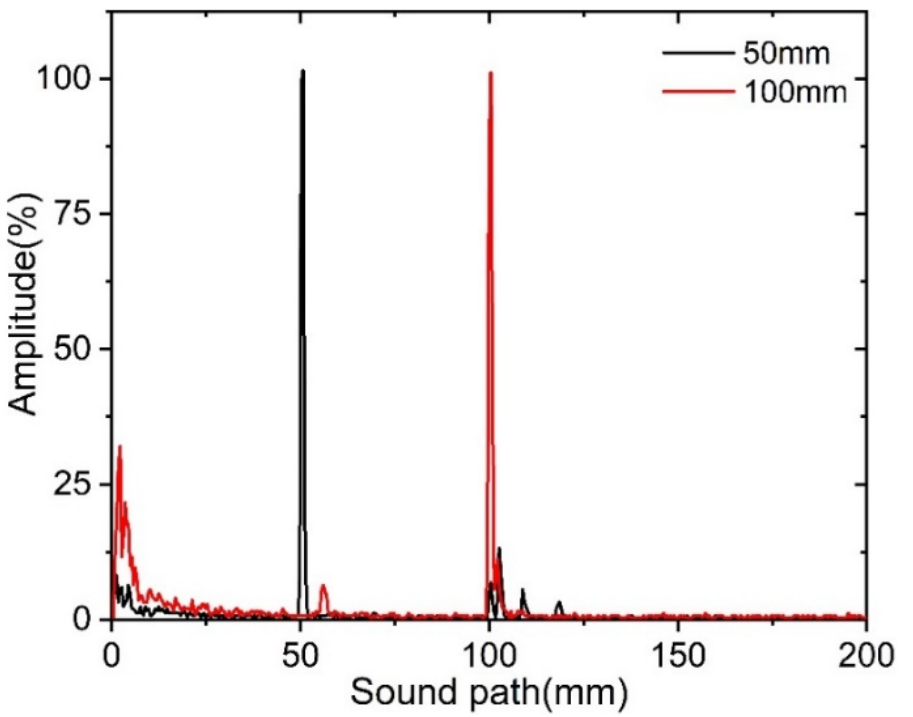
Figure 10. The calibrated ultrasonic echo signals.